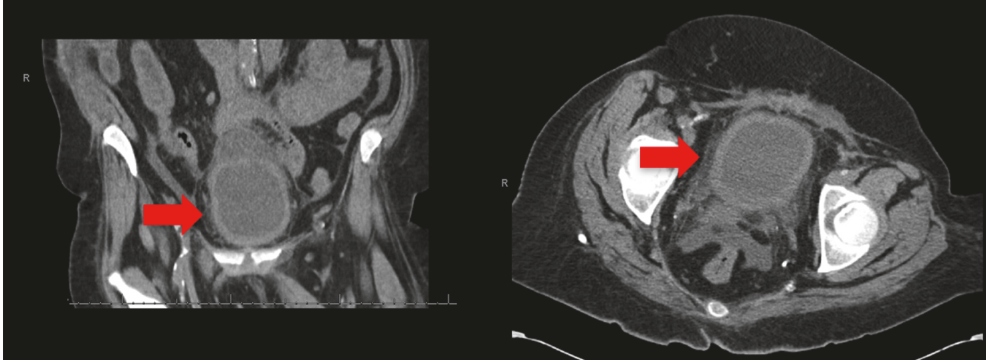
Figure 1: Distended bladder with thickened wall (arrow).